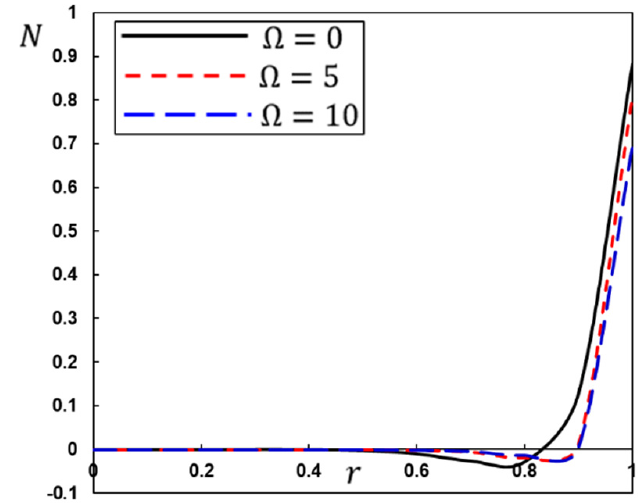
Figure 9. The carrier density N for different rotation parameter Ω .